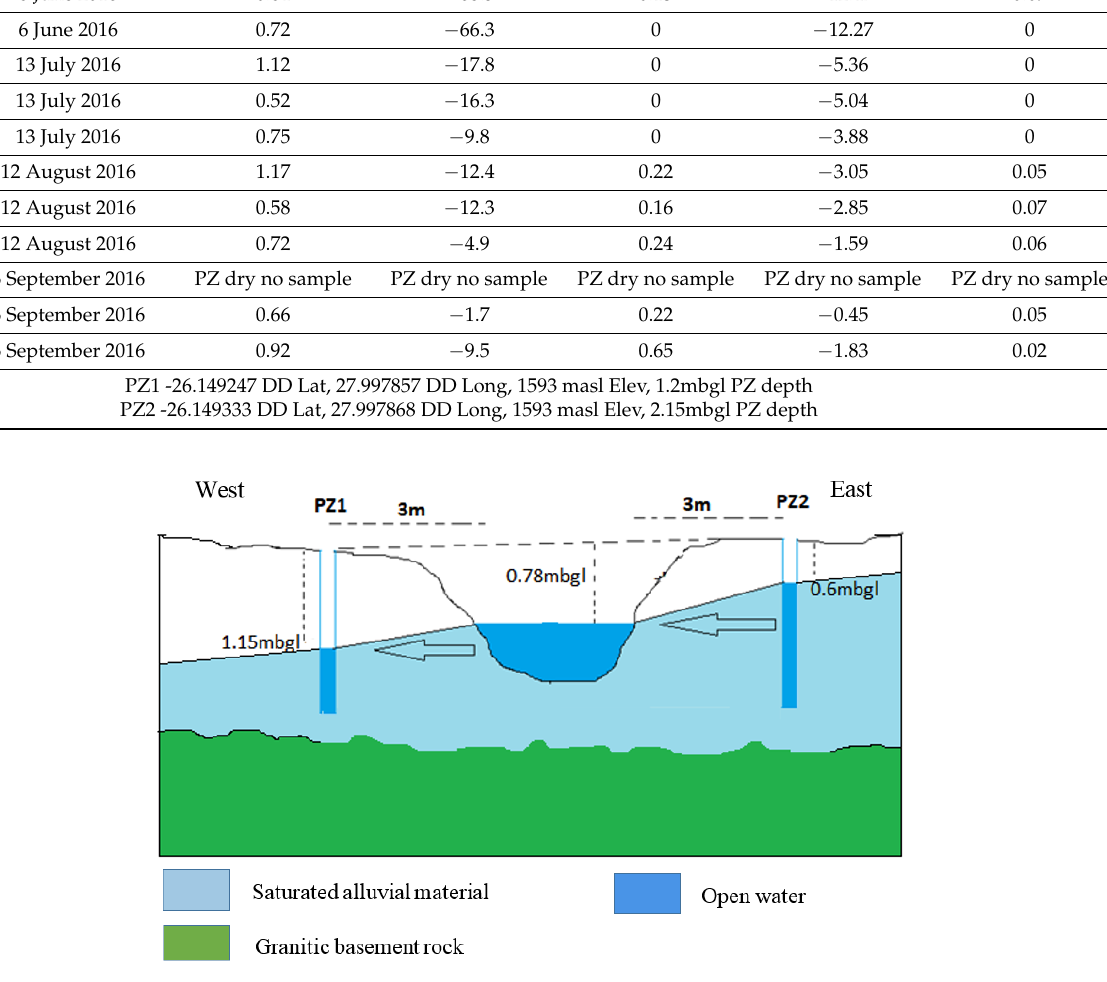
Figure 8. Schematic of stream gain and stream loss at the Montgomery Stream, which is underlain by the granites.